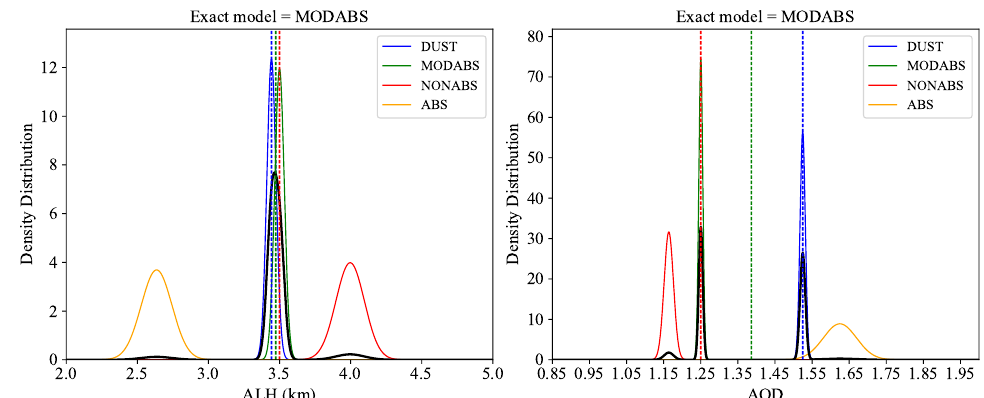
Figure 3. The a posteriori densities p ( x = [ τ , h ] | y δ , m ) for m = NONABS, MODABS, ABS, and DUST, and the mean a posteriori densities p mean ( x = [ τ , h ] | y δ ) in the case m e = MODABS, τ e = 1.25, and h e = 3.5 km. The black curve indicates the mean a posterior density. In each plot, the red vertical dashed line corresponds to the exact values to be retrieved ( τ e , h e ), the blue vertical dashed line to the maximum solution estimate ( τ max , h max ) , and the green dashed line to the mean solution estimates ( τ mean , h mean